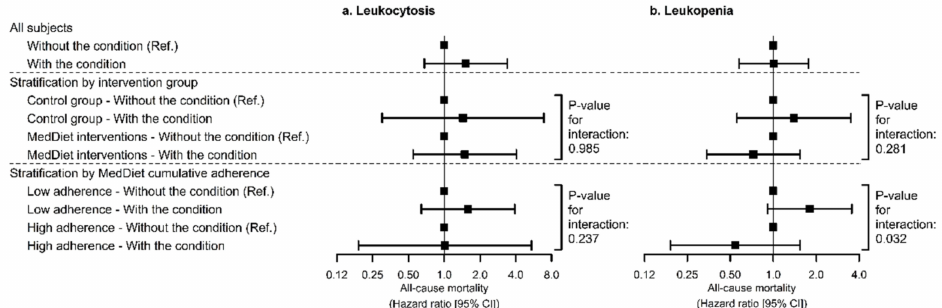
Figure 4. Associations of leukocytosis ( a ) and leukopenia ( b ) with all-cause mortality risk stratified by MedDiet groups. Hazard ratios were estimated by multivariable Cox proportional hazards regression models stratified by sex, recruitment site, and educational level, and adjusted for white blood cell count, age, diabetes, hypercholesterolemia, hypertriglyceridemia, hypertension, smoking habit, leisure-time physical activity, body mass index, hemoglobin levels, and alcohol consumption (at baseline). Analyses stratified according to cumulative MedDiet adherence were further adjusted for PREDIMED intervention group. We used robust standard errors to account for intra-cluster